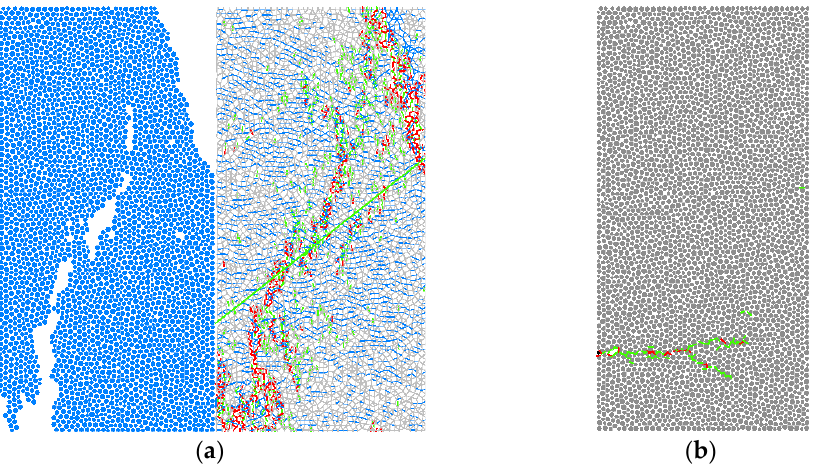
Figure 14. Fitting relationship between uniaxial compression magnification factor ratio and compressive strength.